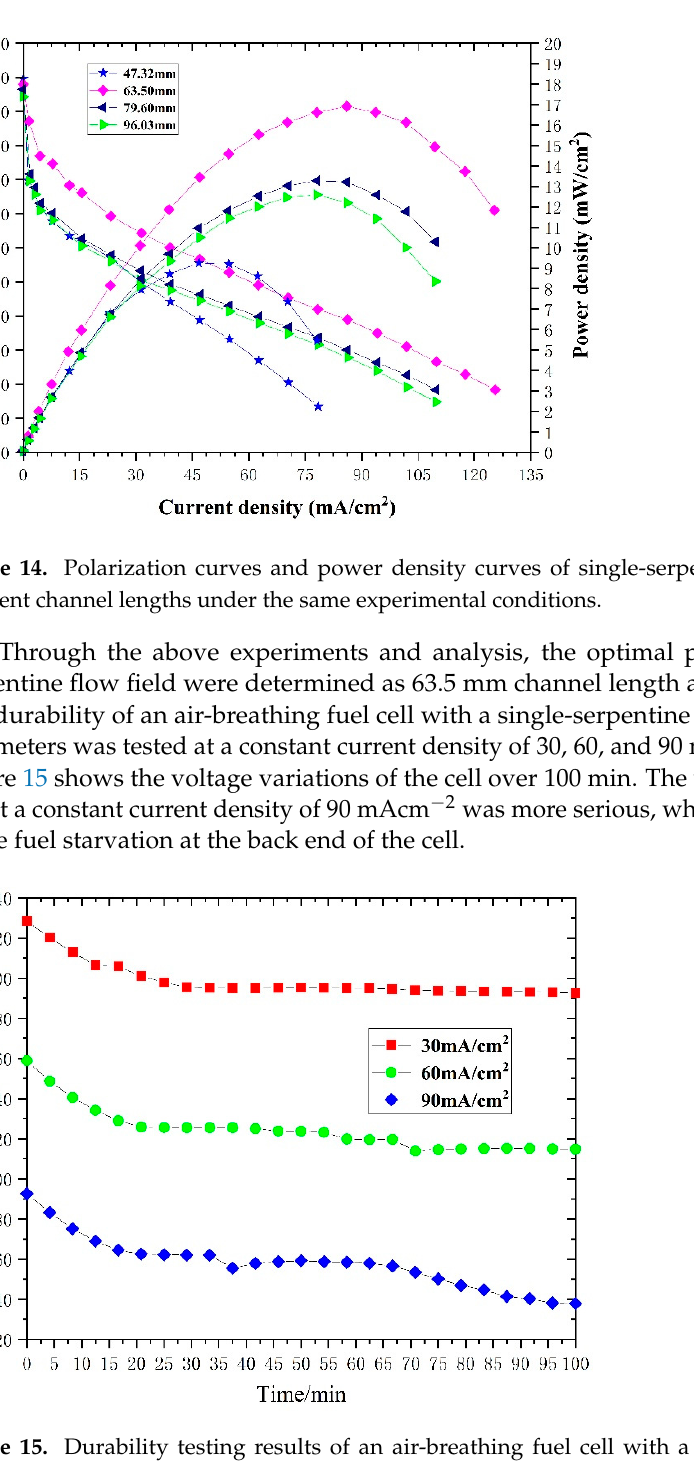
Figure 15. Durability testing results of an air-breathing fuel cell with a single-serpentine flow field at 63.5 mm channel length and 47.3% open ratio at a constant current density of 30, 60, and 90 mAcm − 2 , respectively.